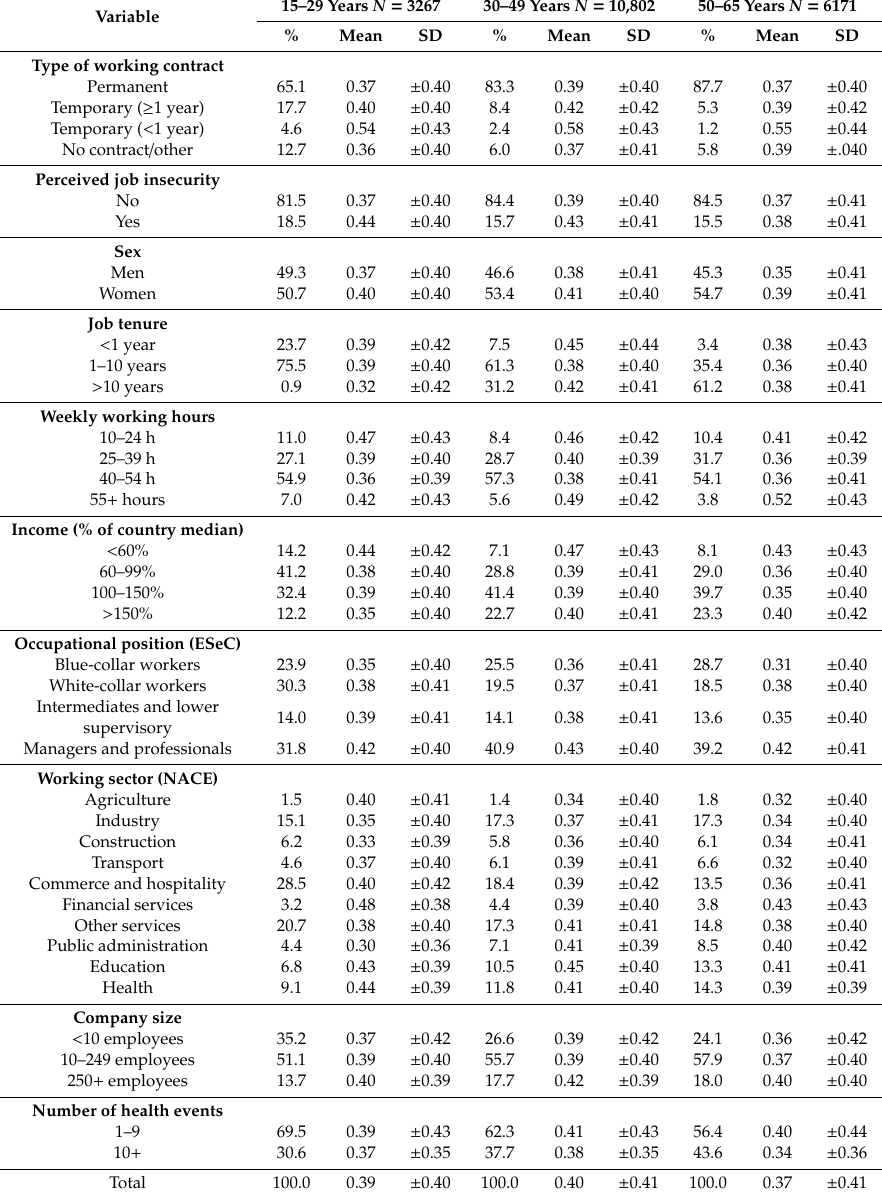
Table 2. Prevalence of covariates and means of presenteeism propensity in di ff erent age groups.